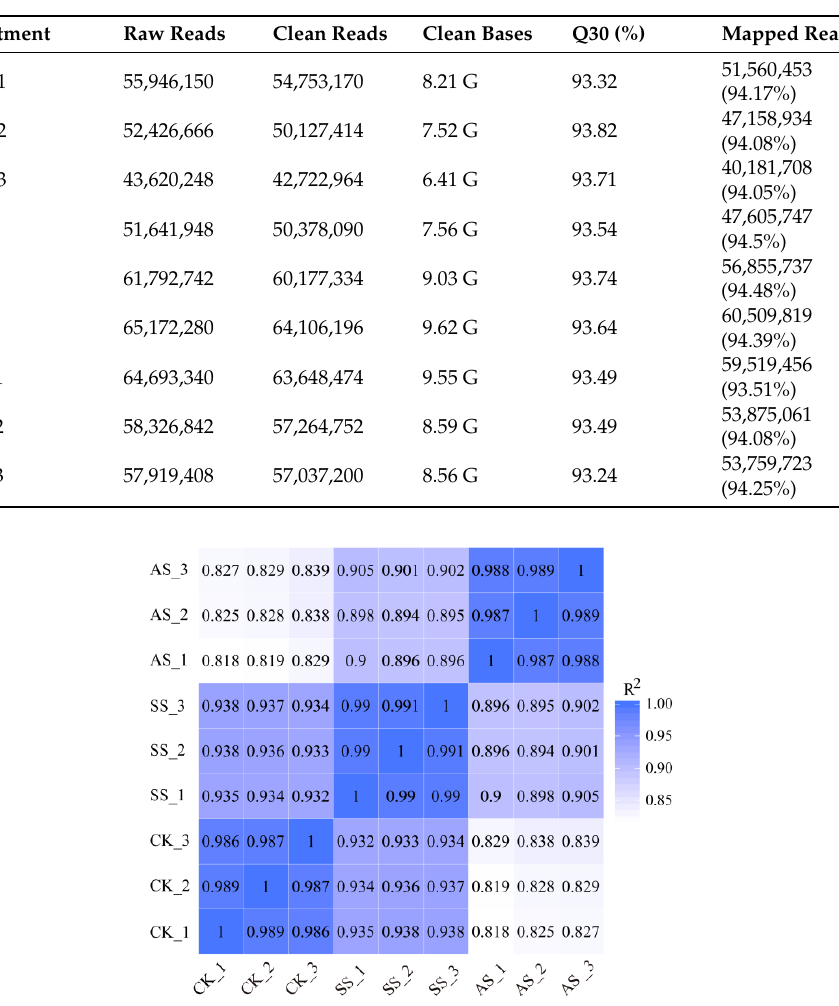
Table 1. Summary of mRNA sequencing datasets.